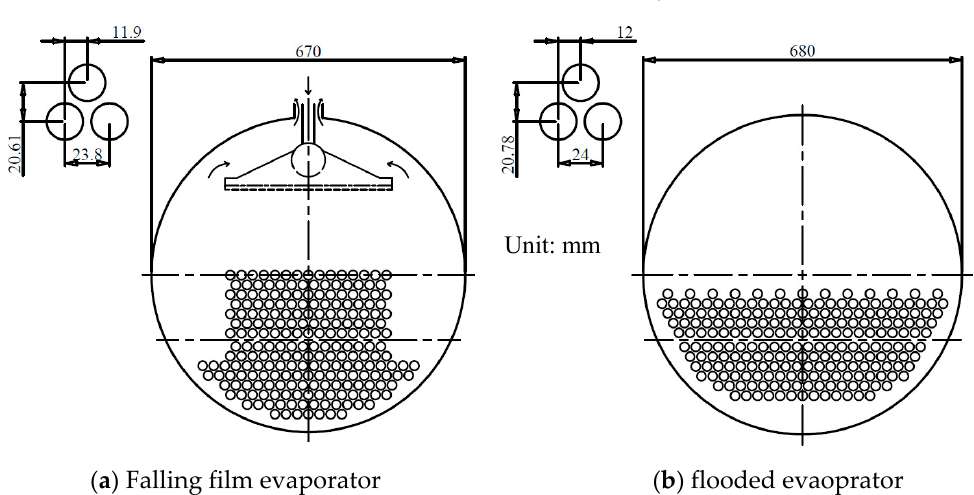
Figure 2. Tube bundle for the falling-film evaporator and the flooded evaporator (unit: mm).